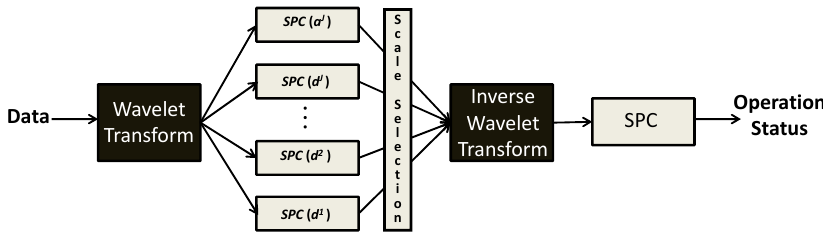
Figure 6. Scheme for the implementation of Multiscale Statistical Process Control.